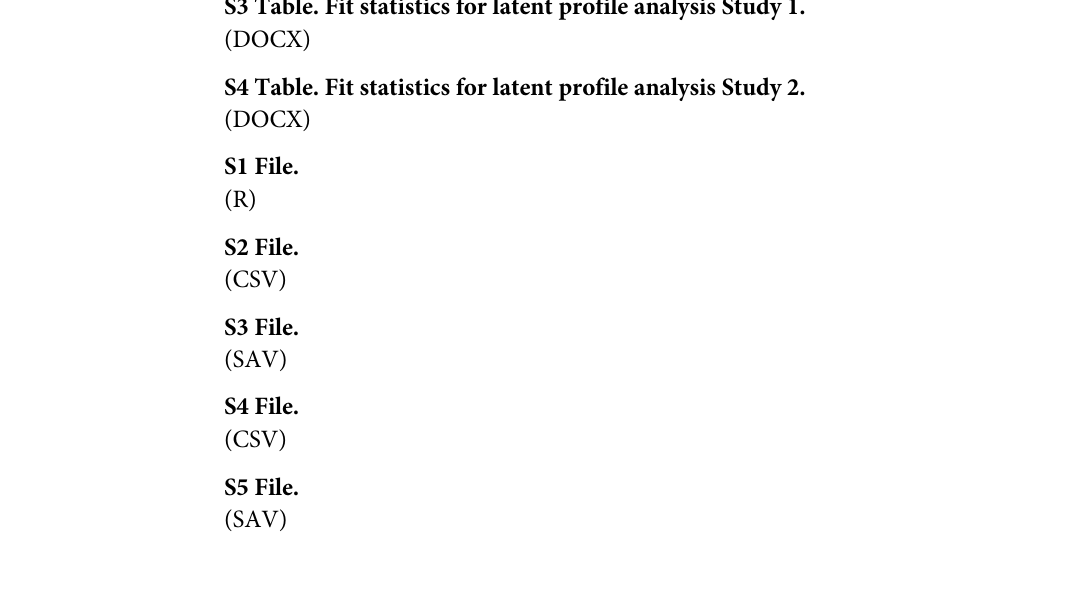
S1 Table. Occupation of participants, Study 1. S2 Table. Occupation of participants, Study 2. S3 Table. Fit statistics for latent profile analysis Study 1. S4 Table. Fit statistics for latent profile analysis Study